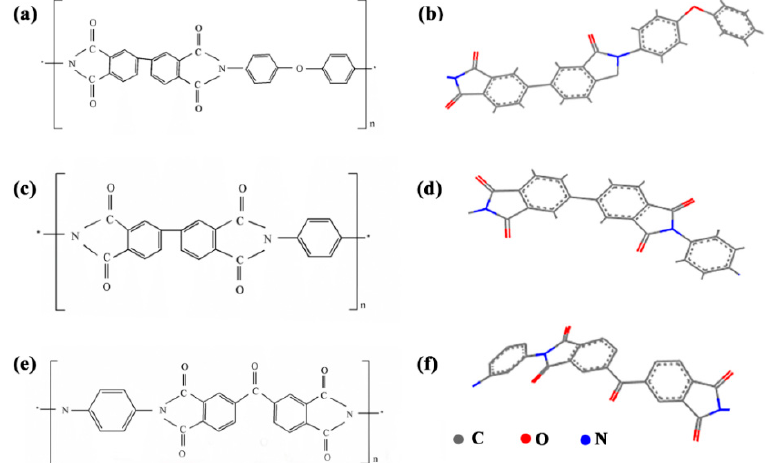
Figure 2. Three types of polyimides with different molecular structures. ( a , b ) BPDA-ODA, ( c , d ) BPDA-PDA, ( e , f ) BTDA-MPD.